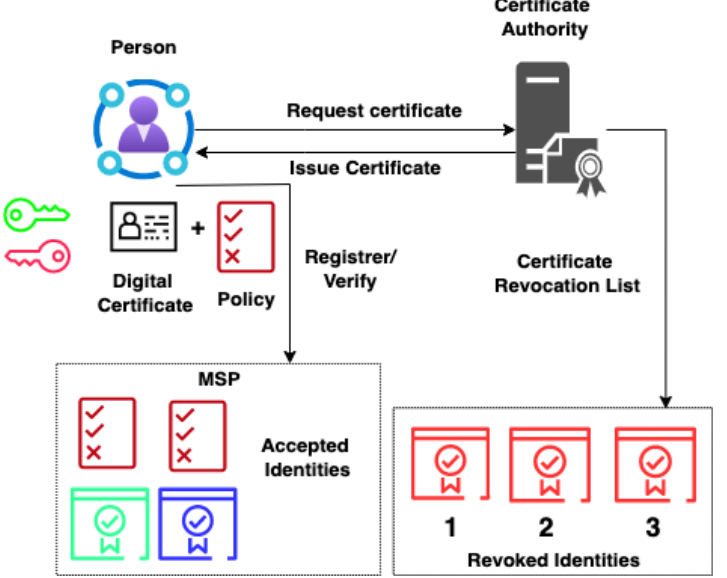
Figure 3. Identity certifications issuing and membership service provider